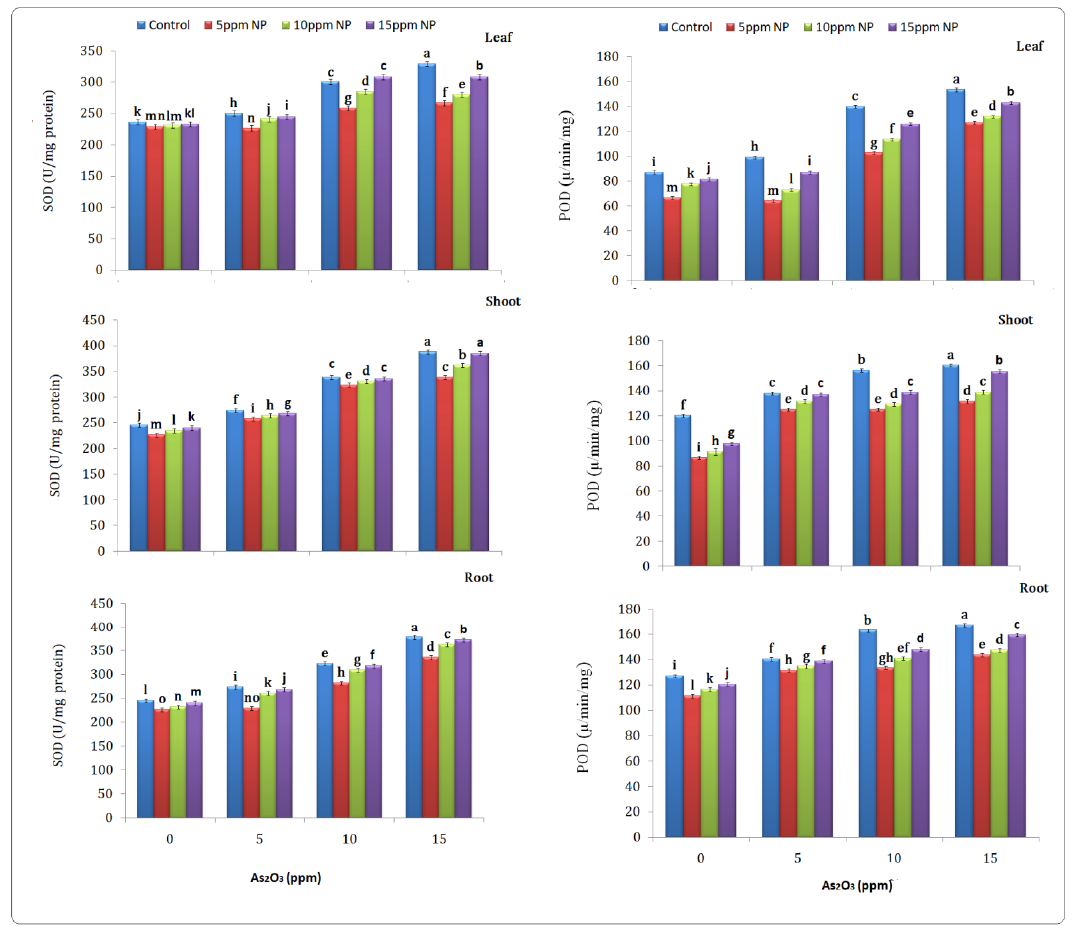
Figure 4. Effect of Bacillus subtilis synthesized iron oxide nanoparticles on SOD and POD content of rice ( Oryza sativa L.) in arsenic-contaminated water. Different letters indicate significant differences ( p < 0.05) between